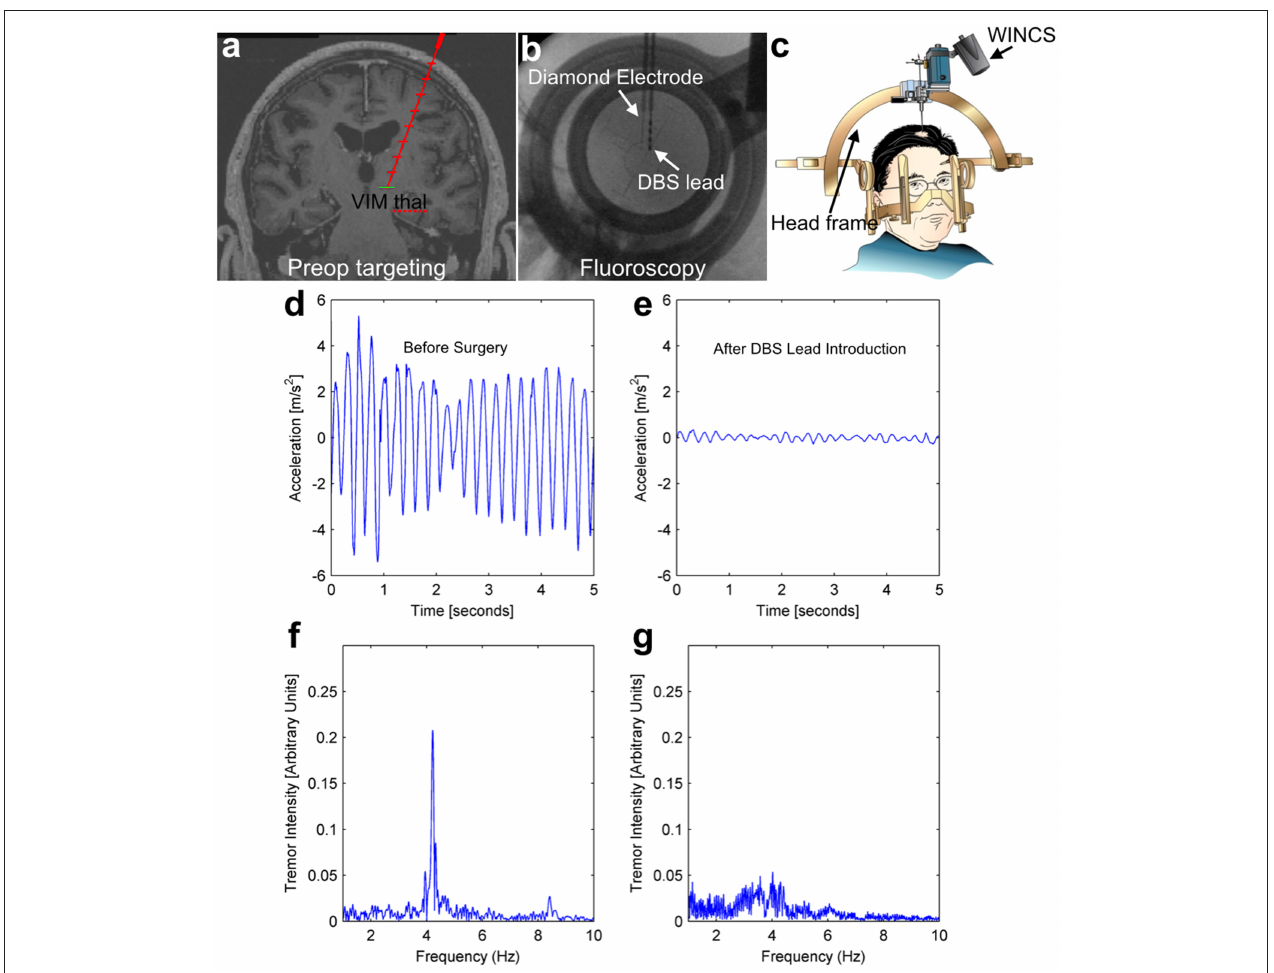
FIGURE 6 | Intraoperative tremor recordings before and after DBS lead placement. This patient underwent DBS lead placement for essential tremor, with the diamond-based electrode placed in the ventral intermediate (VIM) nucleus of the thalamus prior to therapeutic DBS lead placement (top panels A–C ). Throughout the surgery, the patient wore a hand-mounted wireless accelerometer to measure tremor. Prior to surgery, the patient displayed a pronounced tremor at 4.2Hz (left panels, D,F ), while after lead placement the mechanical stimulation alone (“microthalamotomy” effect) caused a cessation of this tremor with no applied voltage (right panels, E,G